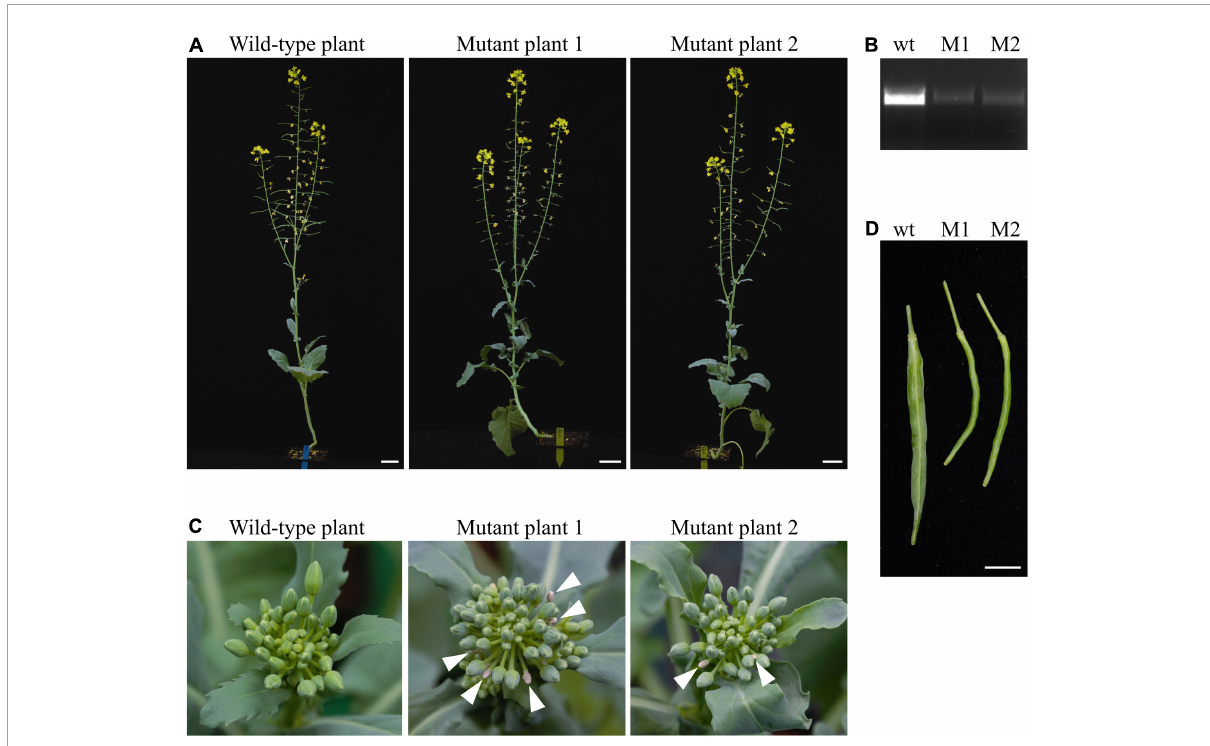
FIGURE5 Phenotypes of BnaTAA1 double mutants. (A) Morphology of T1 plants, free of Ri T-DNA and Cas9 transgene, carrying the homozygous mutations in BnaA02.TAA1 and BnaC02.TAA1 at the same age as the wild-type Brassica napus DH12075 (scale bar = 5 cm). (B) Homozygous indels lead to a reduced BnaTAA1 expression detected by RT-PCR in pistils of T1 mutant plants M1 and M2. (C) Inflorescence meristem (top view) of mutants compared to the wild-type plant. Arrowheads indicate senescent flower buds. (D) Mature green siliques of mutants compared to the wild-type plant (scale bar = 1